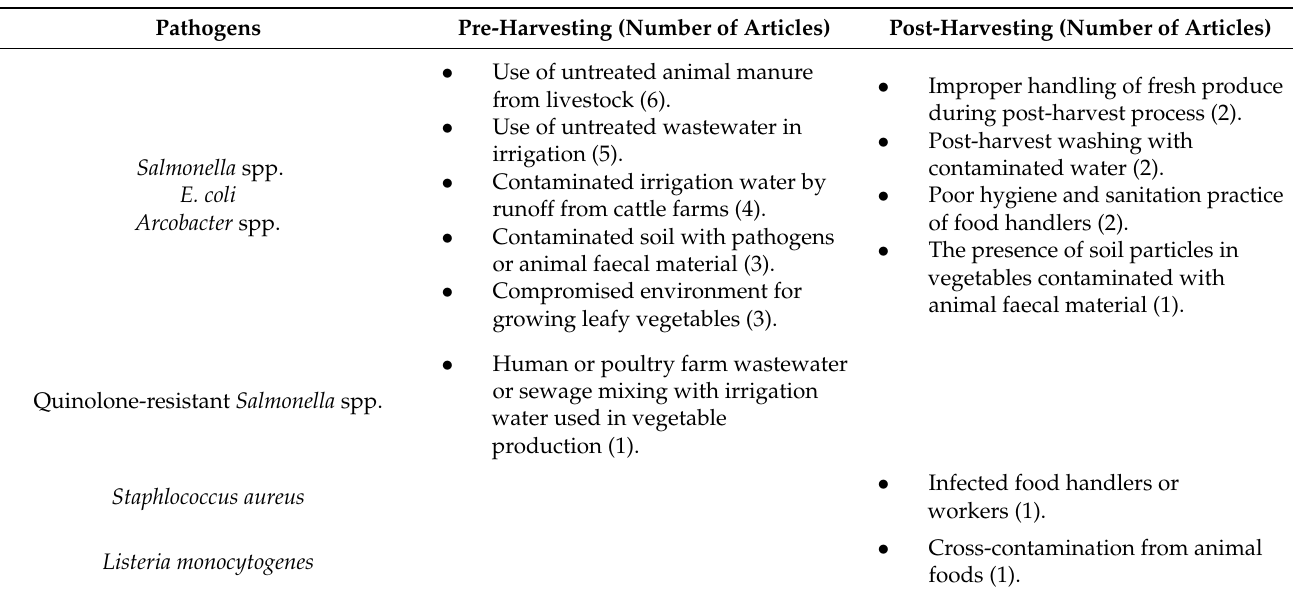
Table 3. Potential pathways of contamination of fresh produce with antimicrobial-resistant bacterial